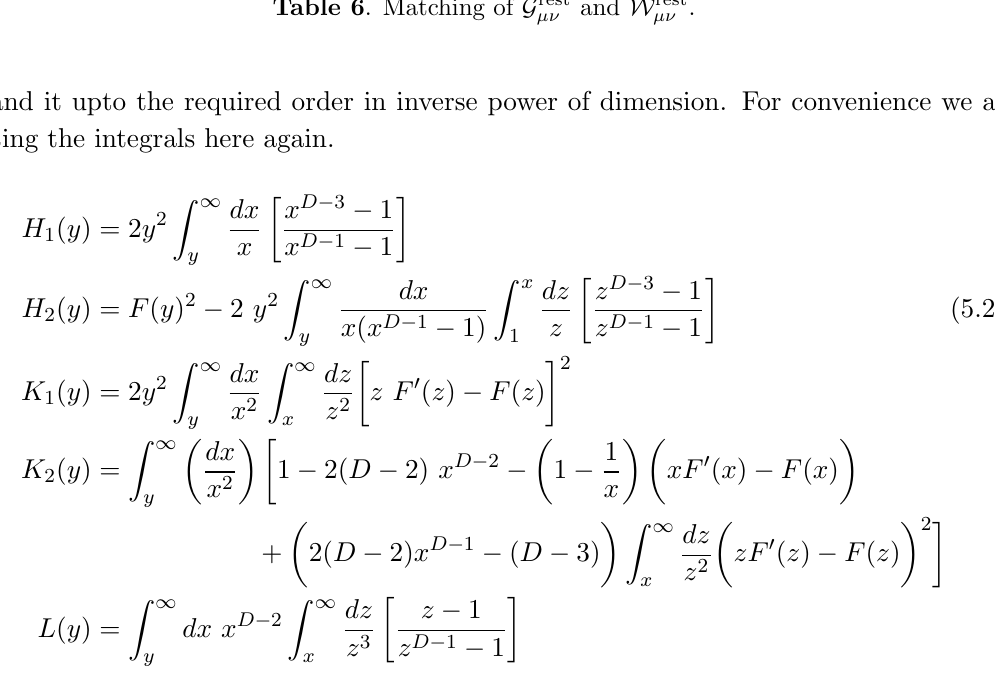
Table 6 . Matching of G rest